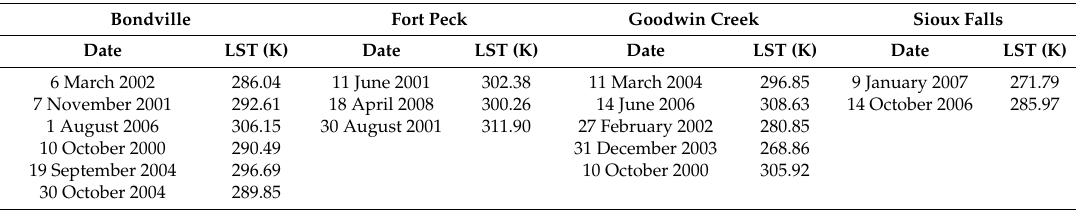
Table 8. LST values derived from the SURFRAD